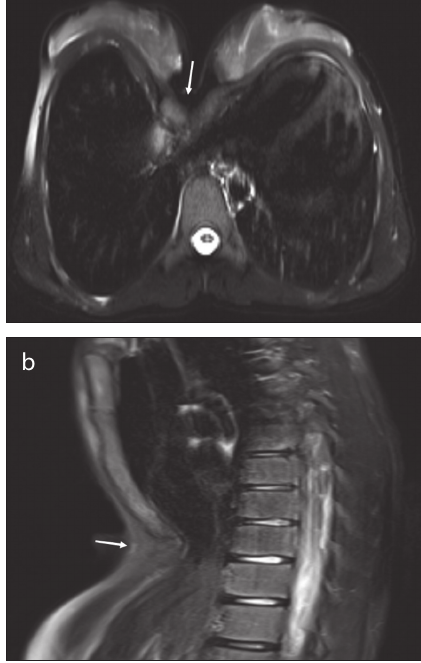
Figure 7. a, b. A 14-year-old female with pectus excavatum. Axial T2-weighted (a) and sagittal T2-weighted (b) images reveal the pectus excavatum deformity (white